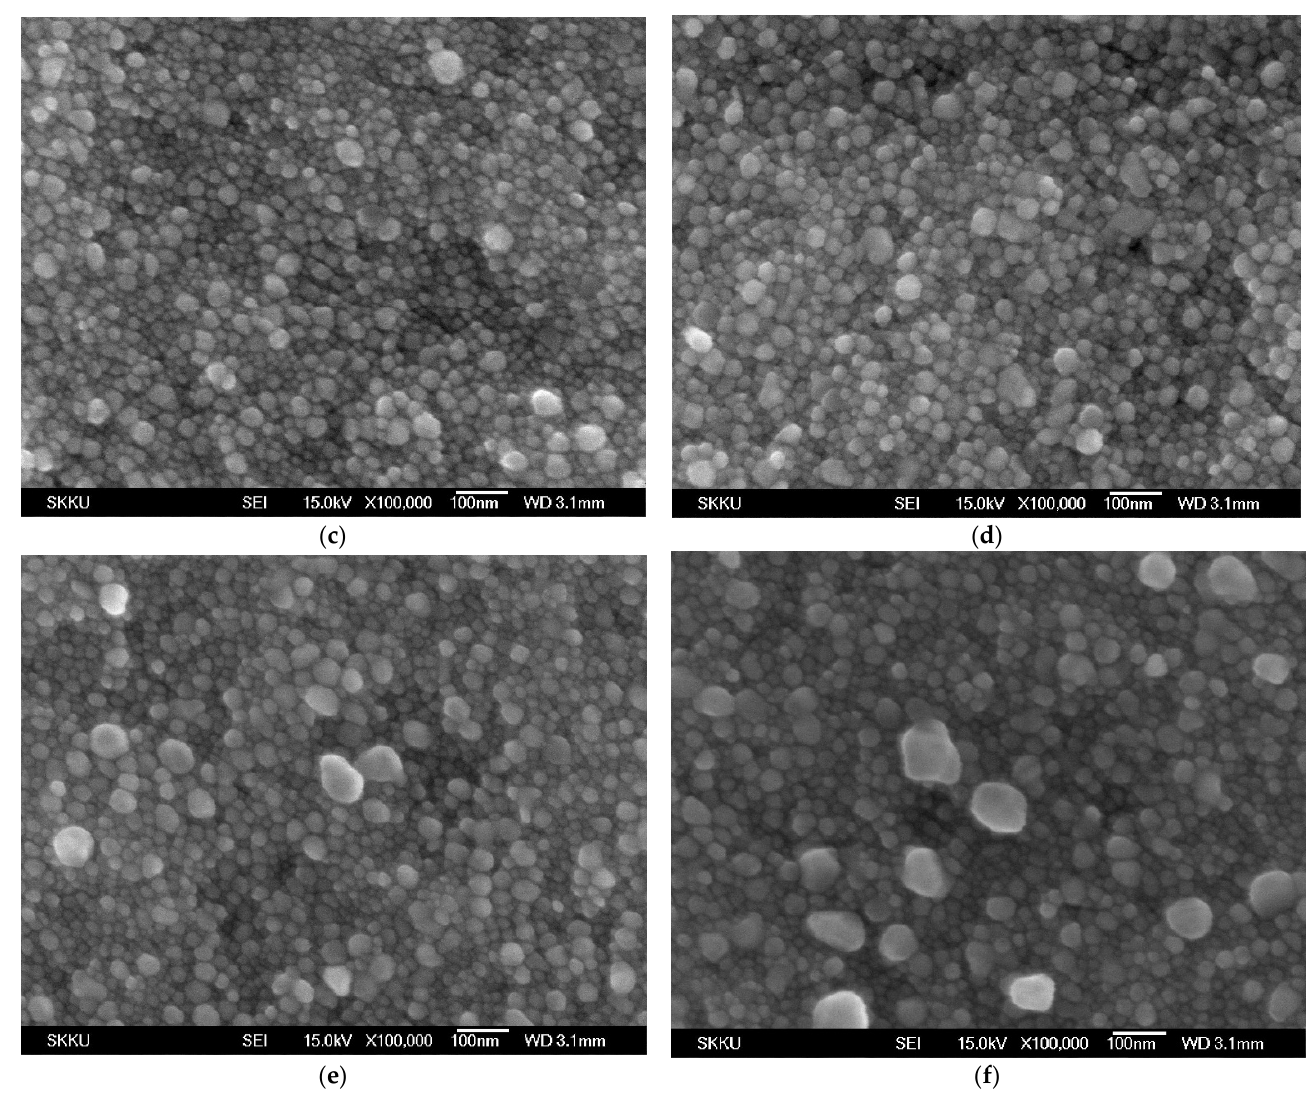
Figure 7. SEM images showing the surface morphology of thermally treated Ag films: as-deposited ( a ), annealed at 90 °C ( b ), 120 °C ( c ), 150 °C ( d ) for 10 min. The sample ( e , f ) were annealed at 150 °C for 30 and 50 min, respectively.